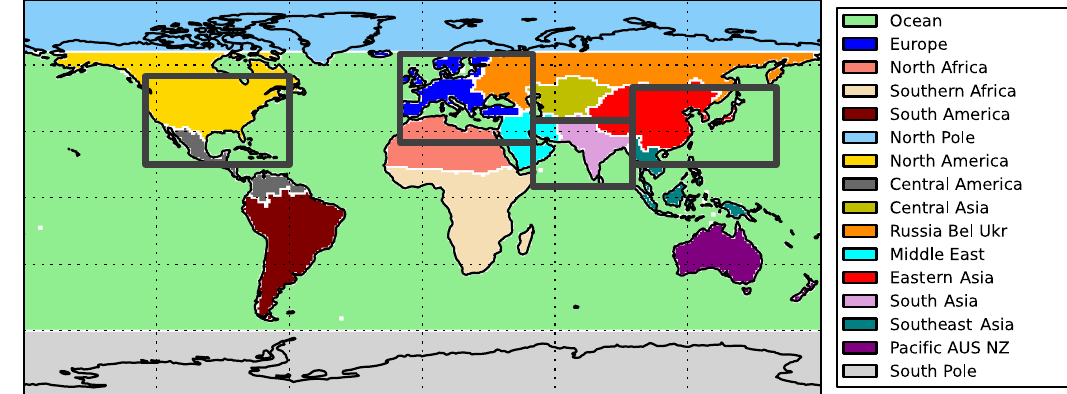
Figure 1. Source–receptor regions used in TF-HTAP2 (coloured regions) and TF-HTAP1 (solid grey line boxes) experiments.